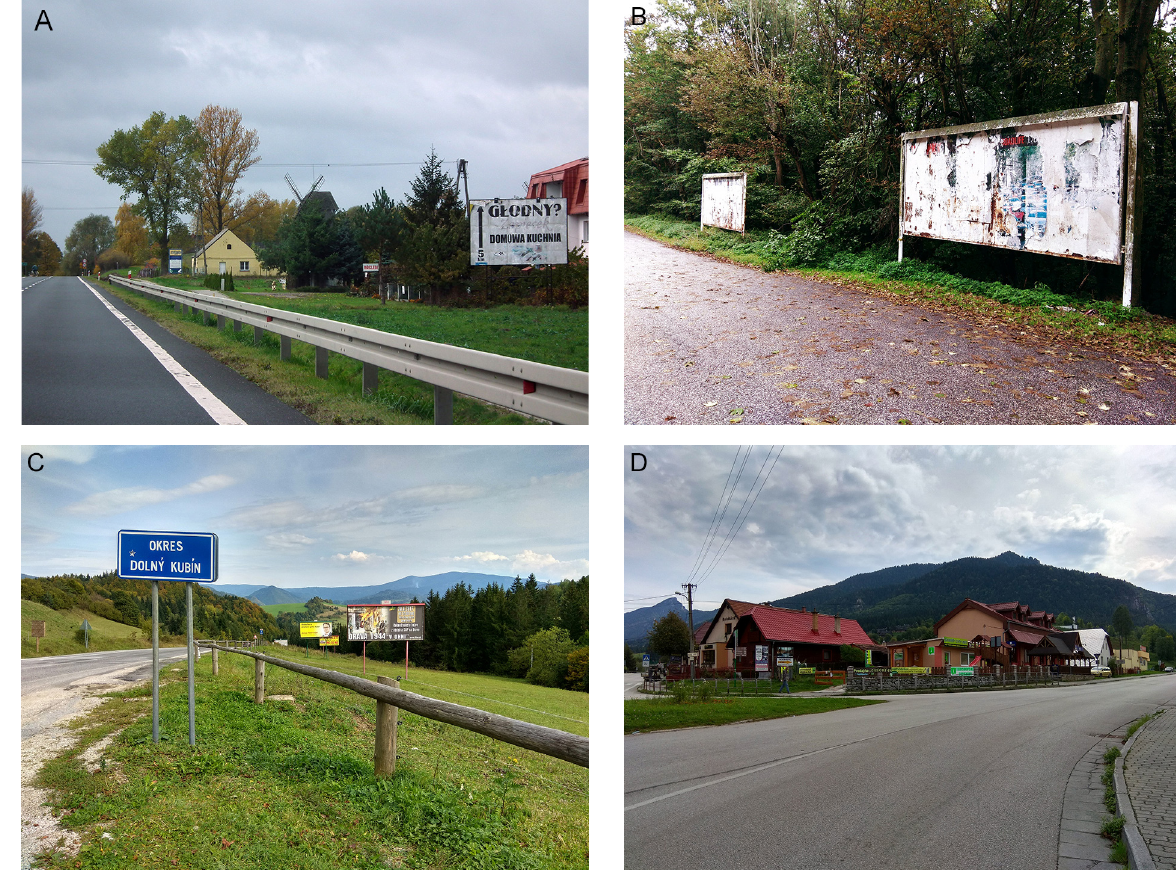
Fig. 4. Examples of not harmonious solutions for the placement of advertisement carriers in relation to a landscape: A – unfavorable location of an advertisement – visual competition with a historic object; B – destroyed and outdated ads degrading a landscape; C – unfavourable location of an advertisement – competing visually with a protected landscape and information signs; D – information